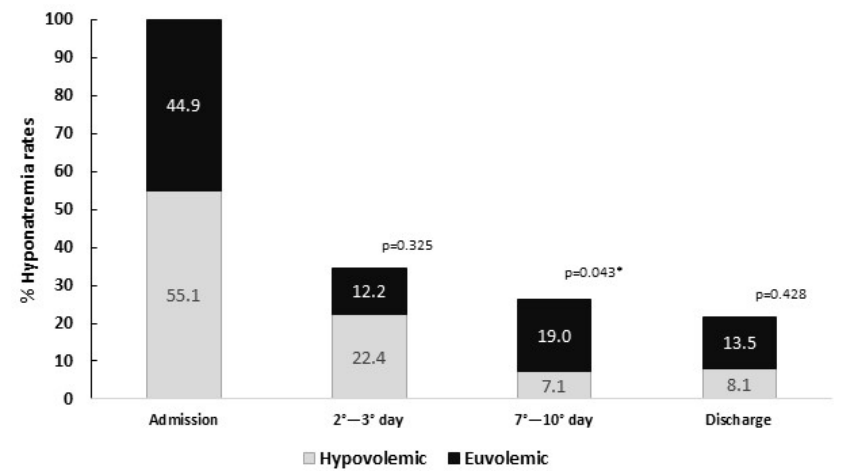
Figure 1. Evolution of hyponatremia rates during hospitalization, grouped as hypovolemic and euvolemic. p value represents the statistical significance of the analysis of difference of ratios between hypovolemia and euvolemia. p -value indicates statistical differences between hypovolemic and euvolemic. * p < 0.05.